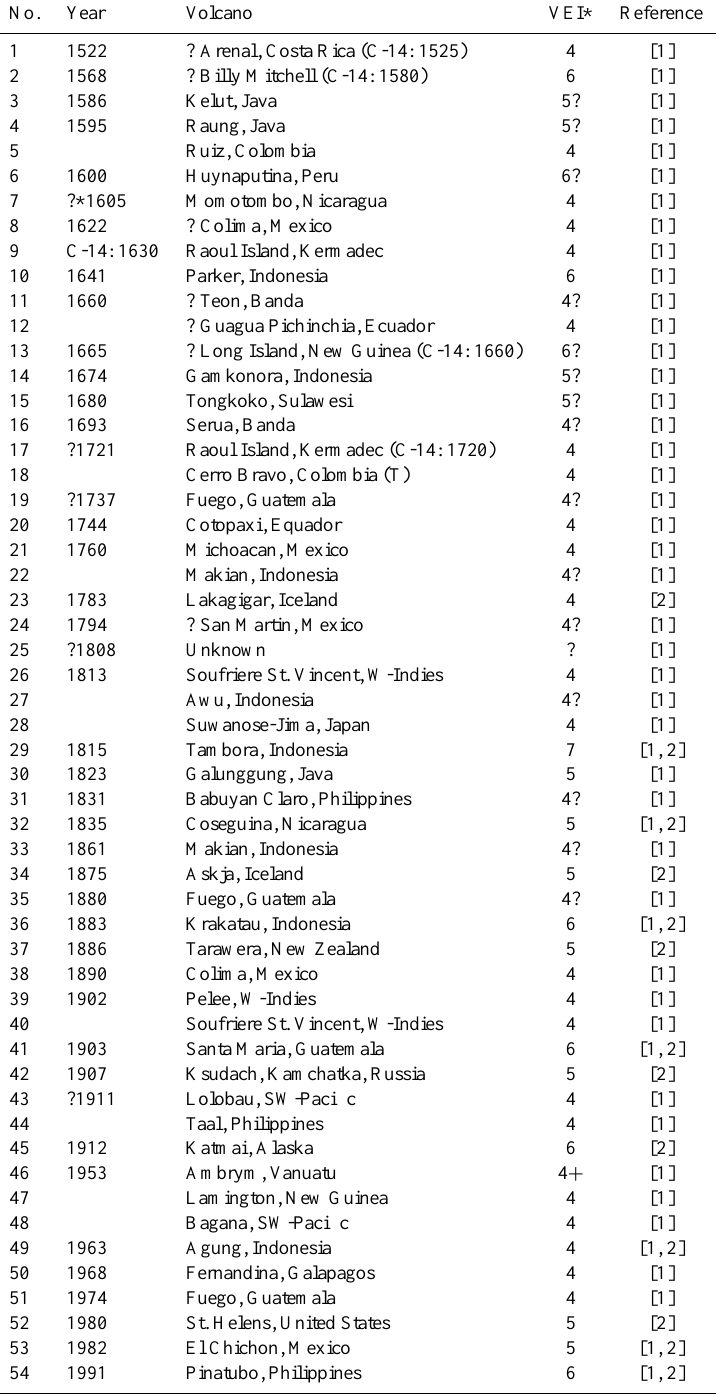
Table B1. Volcanic eruptions in 1500–2000 with volcanic explosivity index (VEI) of 4 or